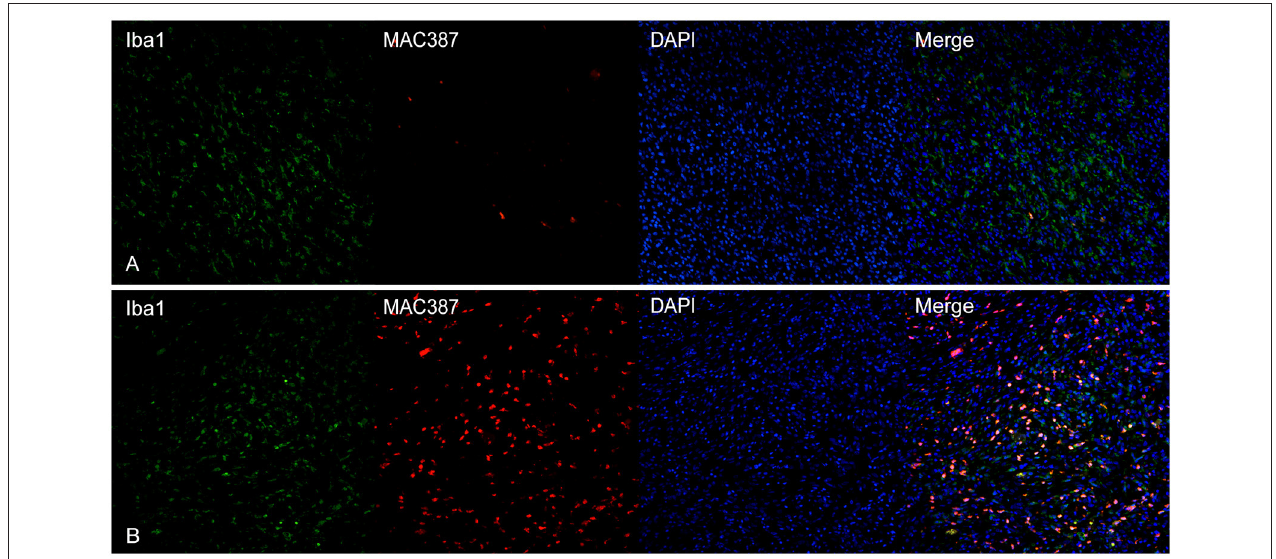
FIGURE 5 | (A) Canine, oral melanoma. Colocalization of Iba1 (green) and MAC387 (red). In melanomas, MAC387 + cells were few and often did express also Iba1. (B) Canine, cutaneous melanoma. In areas near superficial ulceration, the number of cells co-expressing Iba1 and MAC387 was elevated. Nuclear counterstain was performed with